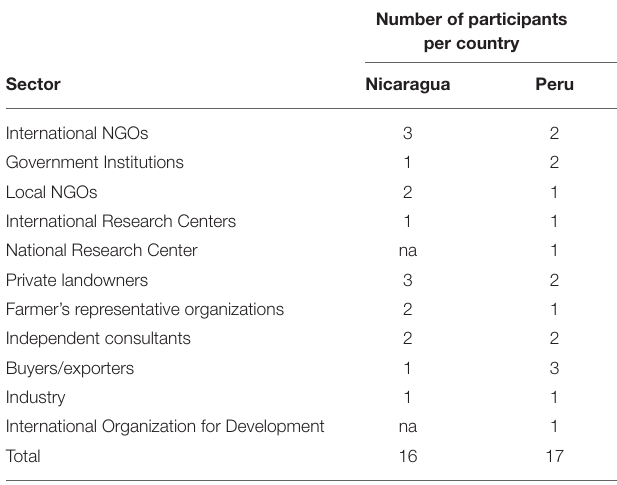
TABLE 2 | Experts interviewed from different sectors across the value chain in Nicaragua and